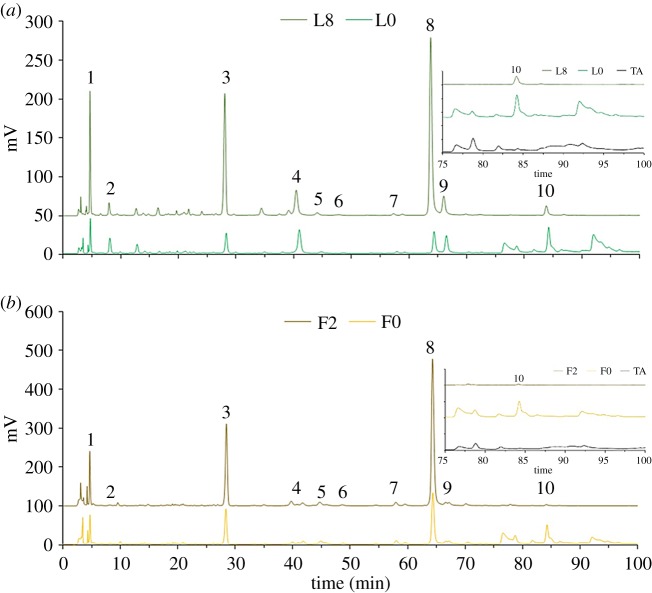
HPLC profiles of ATL and ATF with and without thermal treatment. All chromatographs of ATL (a) and ATF (b) were obtained under the same HPLC condition described. Insets on the upper right corner of (a) and (b) are the enlargement of (a) and (b) between 75 and 100 min, respectively, together with corresponding chromatographs of tannic acid. ‘L0’ and ‘L8’ represents ATL for thermal treatment at 0 and 8 h; ‘F0’ and ‘F2’ represents ATF for thermal treatment at 0 and 2 h.